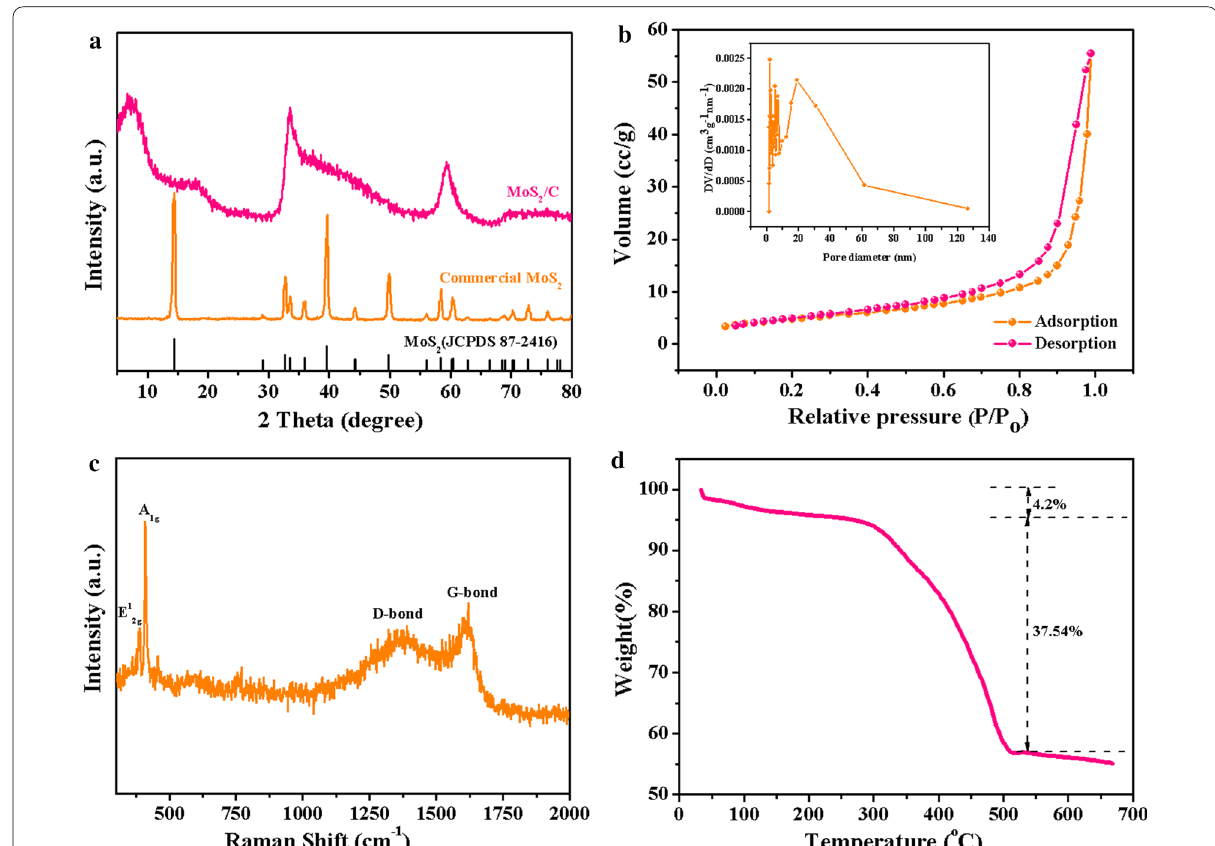
Fig. 2 a XRD patterns of commercial MoS 2 and MoS 2 /C nanospheres; b N 2 adsorption/desorption isotherms and pore size distribution of MoS 2 /C nanospheres; c the Raman spectrums of